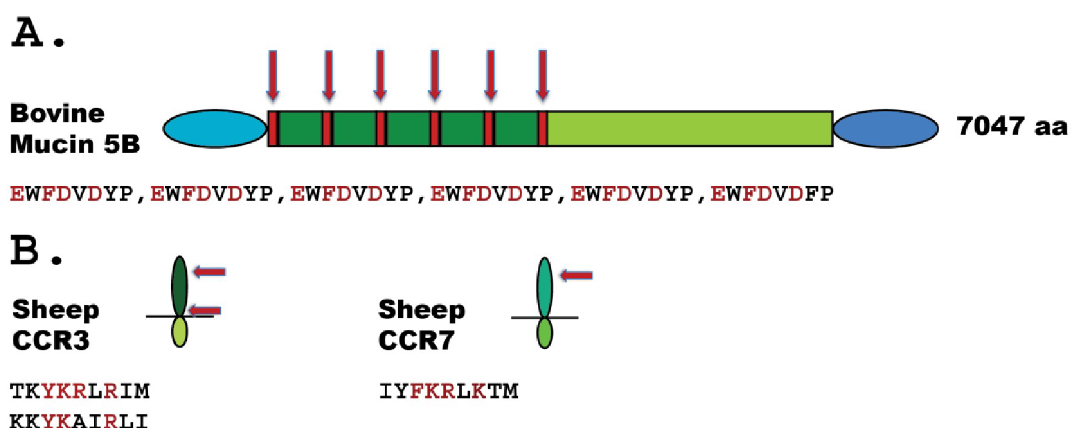
Fig 13. Schematic representation of three potential targets for bovine MCP1A and sheep MCP3-like. In panel A, we show a schematic picture of bovine Mucin 5B with the different regions of the protein marked in different colours and where the six consensus sites for bovine MCP1A are marked by red arrows. The sequence of the six potential cleavage sites are listed below the schematic figure. In panel B, we show the schematic structure of two chemokine receptors having potential cleavage site for sheep MCP3-like. The position of the membrane is marked with a black line and the potential cleavage sites by red arrows. The sequences of the potential cleavage sites are listed below the schematic figure.